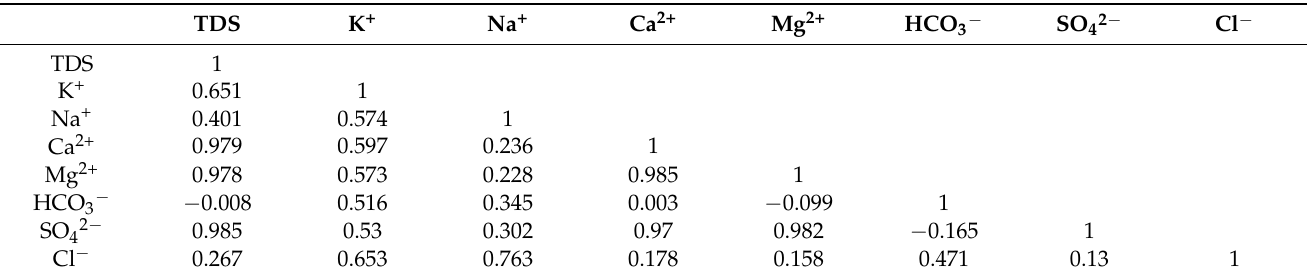
Table 3. Geothermal water sample ion correlation analysis